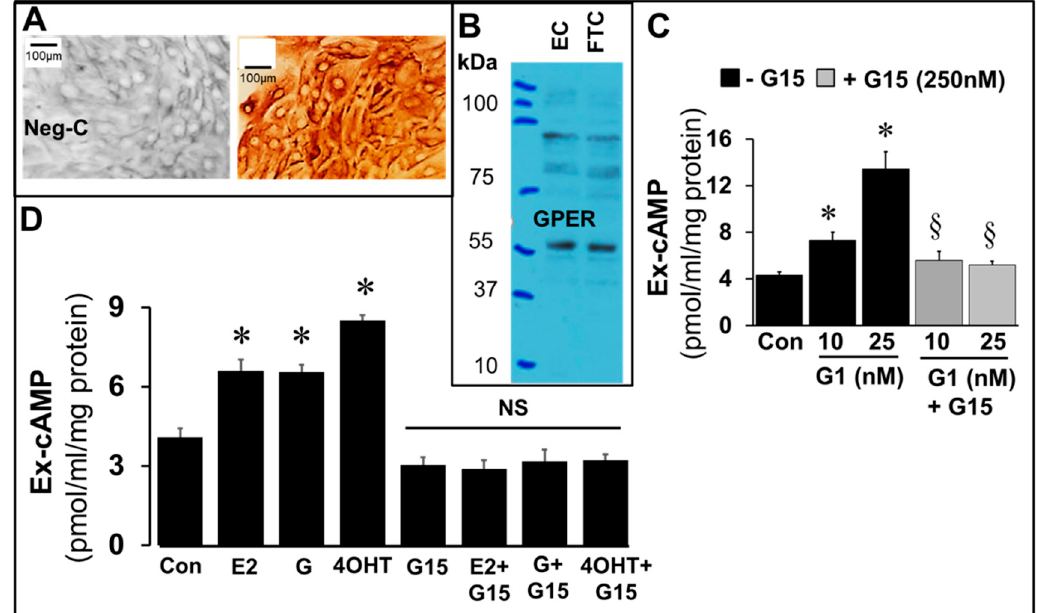
Figure 10. Panel ( A ) depicts representative photomicrographs (40× magnification) of bovine fallopian tube cells (FT cells; mixed cultures of epithelial cells and fibroblasts at 1:1 ratio). The photomicrograph on right depicts FT cells with positive staining for GPER whereas the left photomicrograph depicts the negative control (neg-C). Panel ( B ) shows a western blot for GPER ( ≈ 55 kDa) in FT cells (FTC) and vascular endothelial cells (EC). The bar graph in Panel ( C ) depicts the inhibitory effects of G15 (GPER antagonist; 250 nM) on extracellular (Ex) cAMP levels induced by G1 (25 nM) whereas Panel ( D ) shows the inhibitory effects of G15 (250 nM) on 17 β -estradiol (E2; 20 ng/mL), genistein (G; 20 ng/mL) and 4OH-TCB (4OHT; 20 ng/mL). Data (mean and SEM) represent the mean of three different experiments ( n = 3) in triplicates. Values were normalized to total protein concentration and cAMP level expressed as pmol/mL/mg protein. * p < 0.05 vs. control; § p < 0.05 vs. G1